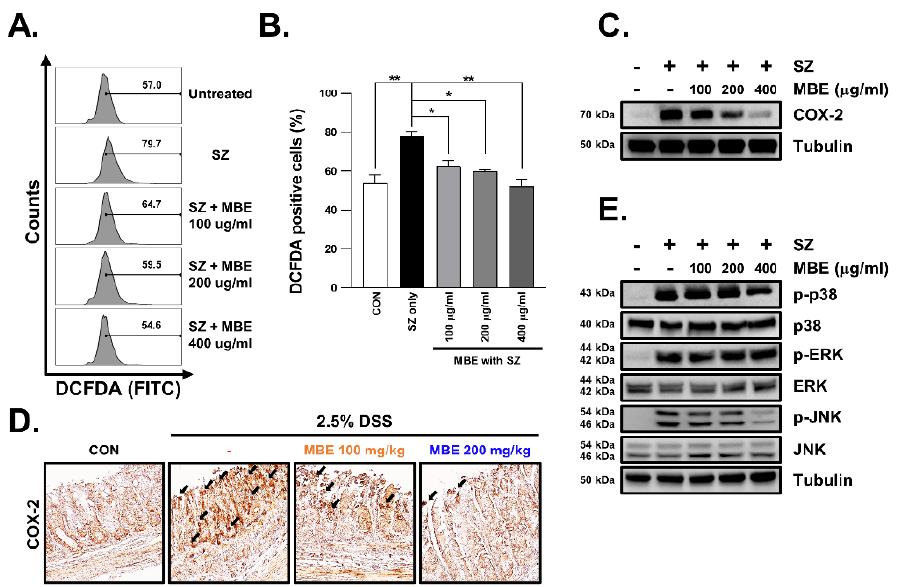
Figure 4. MBE reduces ROS production and the expression of COX2, pp38, and pJNK in SZ-induced necroptosis. ( A ) HT29 cells were pretreated with MBE for 30 min and then treated with SZ (Smac mimetic (100 nM) and z-VAD (20 µ M)) for 12 h. Intracellular ROS was detected as DCFDA fluorescence using flow cytometry. ( B ) The number indicates increased DCFDA fluorescence in A. ( C ) Immunoblotting was performed using proteins extracted from HT29 cells. Tubulin was used as an internal control. ( D ) Representative immunohistochemical staining of COX2 in large intestinal sections. Scale bar, 100 µ m. ( E ) Levels of pp38, p38, pERK, ERK, pJNK, and JNK analyzed using immunoblotting. Tubulin was used as a loading control. * p < 0.05 and ** p < 0.01 (data were analyzed using an ANOVA).